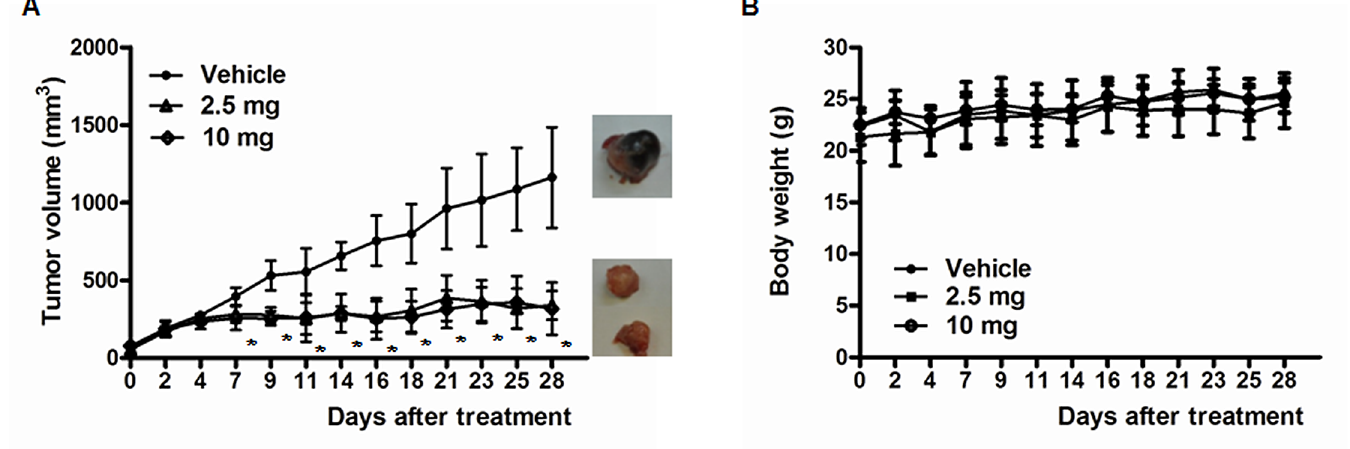
Fig 6. KML001 treatment has (A) a growth inhibitory effect on DU145 prostate cancer cells in mice, and (B) no effect on body weight of mice. Vehicle and KML001 group mice orally received saline and KML001 (2.5 or 10 mg/kg/d) for 4 weeks, respectively. * p < 0.05 vs.